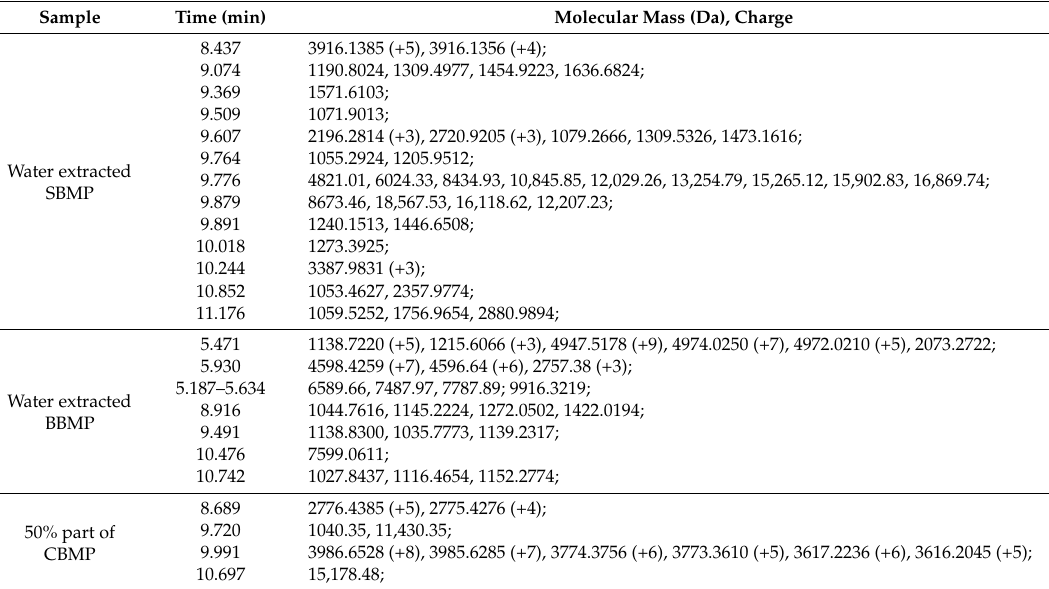
Table 7. LC–MS data analysis of four extraction